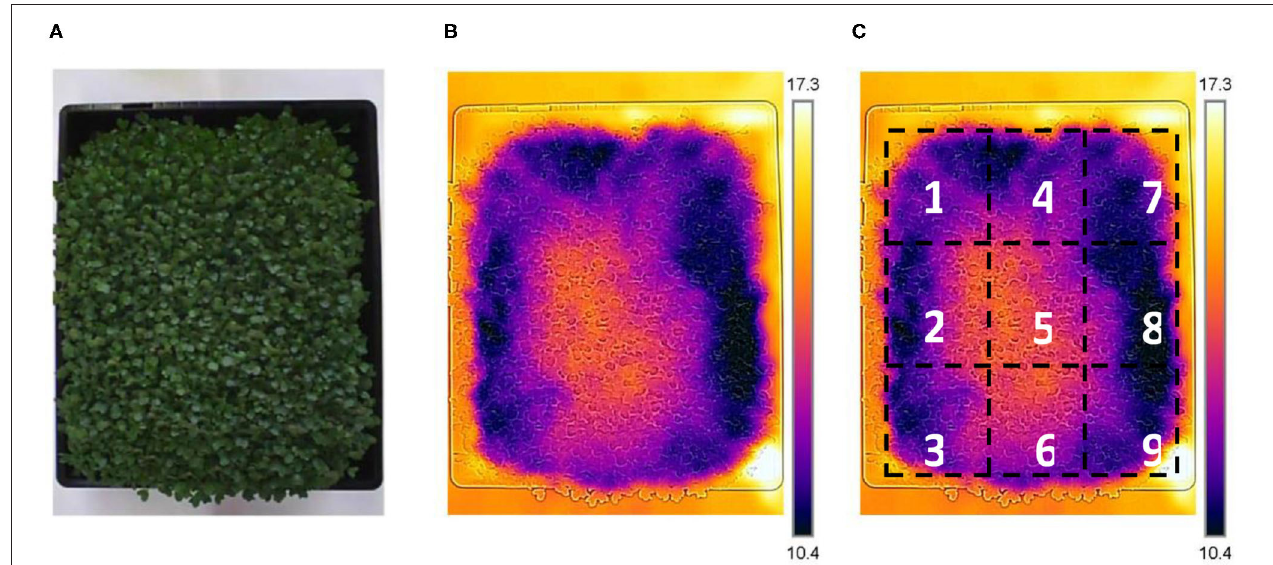
FIGURE 3 | Sample thermal image taken by FLIR camera. Image (A) shows a normal photo, image (B) ; an infrared thermal photo and image (C) , 3 × 3 subdivision of a thermal image to extract data from various sections of the growing